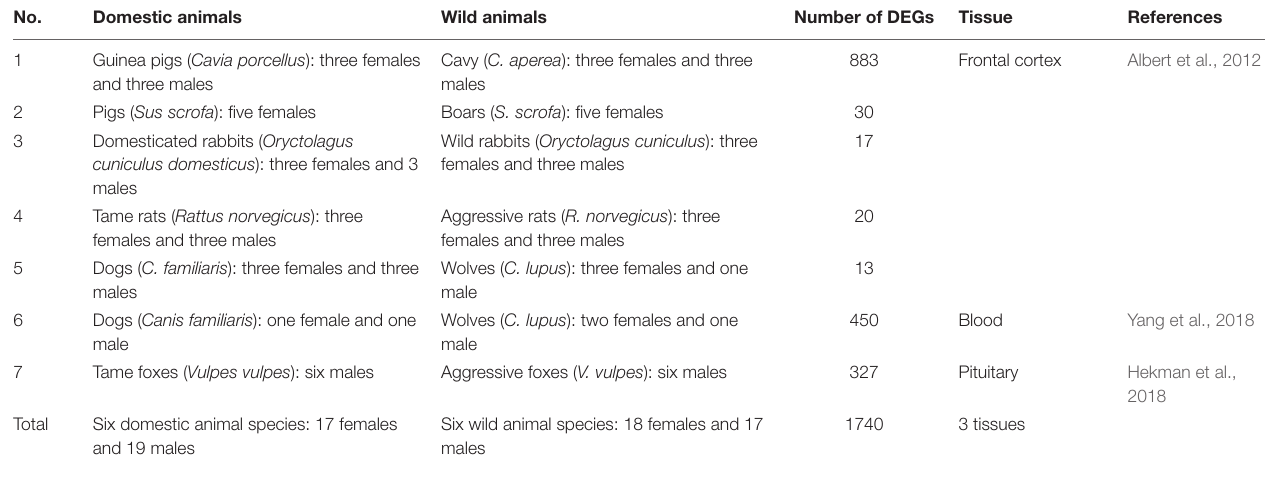
TABLE 1 | The investigated genome-wide RNA-Seq transcriptomes of domestic animals with their wild congeners publicly available in database PubMed.